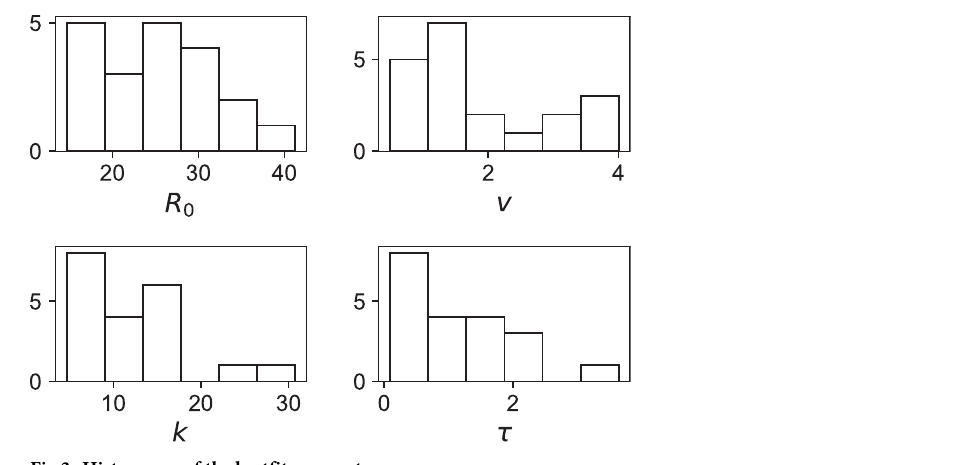
Fig 3. Histograms of the bestfit parameters.